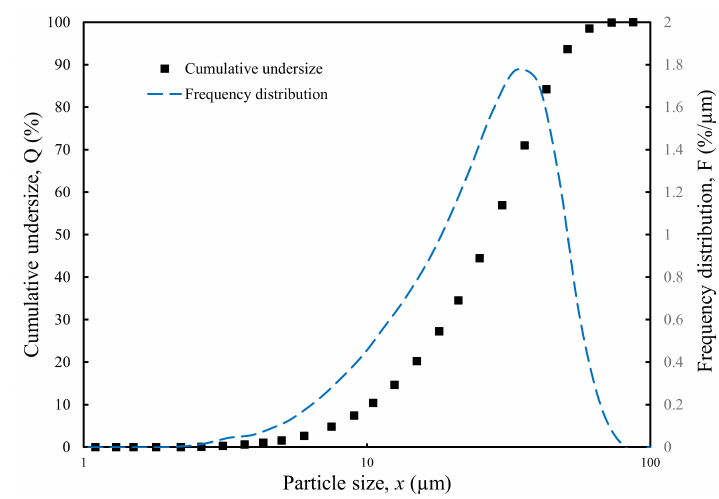
Figure 1. Size distribution of Al alloy